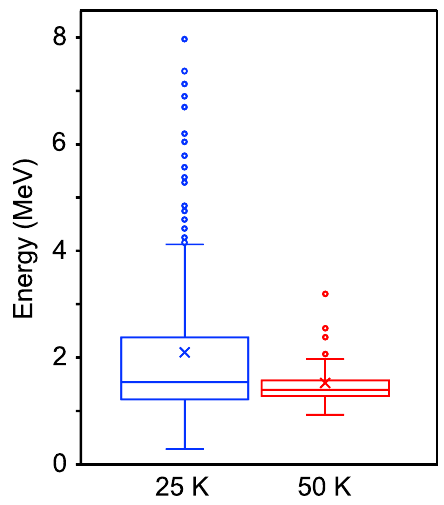
Figure 4. Statistical analysis highlights the existence of markedly high energy protons. Box-and-whisker plot for the maximum energies of the each data set for nozzle temperatures of 25 K (blue) and 50 K (red). The box is drawn from the 25th percentile (Q1) to the 75th percentile (Q3), with a horizontal line drawn in the middle to denote the median, and the cross mark represents the mean of the data set. The circles demonstrate outliers, which are defined as values greater than 1.5 IQR plus the third